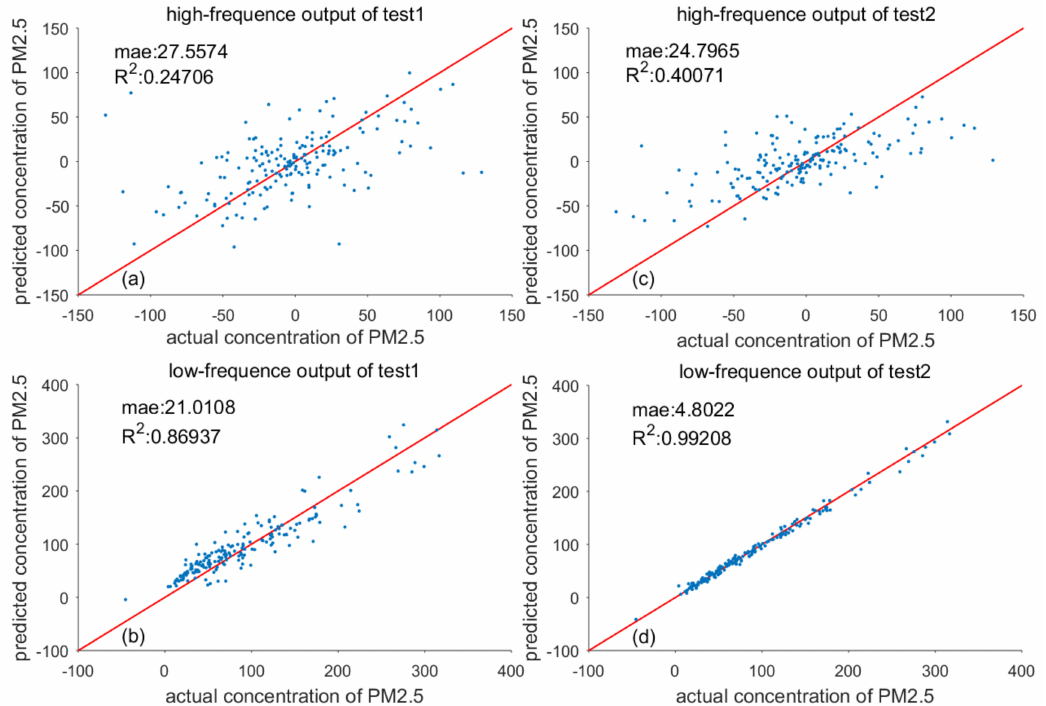
Figure 5. Comparison of observed and predicted values for high-frequency modes (IMFs 1 and 2) and low-frequency modes (IMFs 3 to 8) with different models. ( a ) MAE and correlation coefficient for high-frequency modes (IMFs 1 and 2) for test 1; ( b ) MAE and correlation coefficient for high-frequency modes (IMFs 1 and 2) for test 2; ( c ) MAE and correlation coefficient for low-frequency modes (IMFs 3 to 8) for test 1; ( d ) MAE and correlation coefficient for low-frequency modes (IMFs 3 to 8) for test 2.